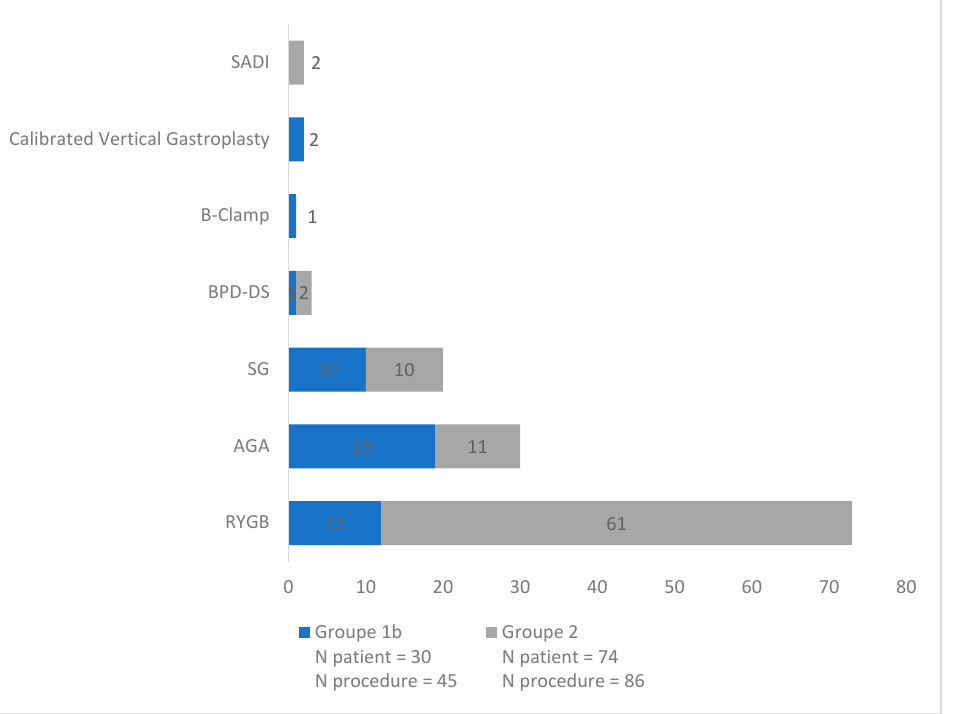
Figure 1. Type of surgery by frequency ( n = 131). Table 1. Patients’ general characteristics at baseline.